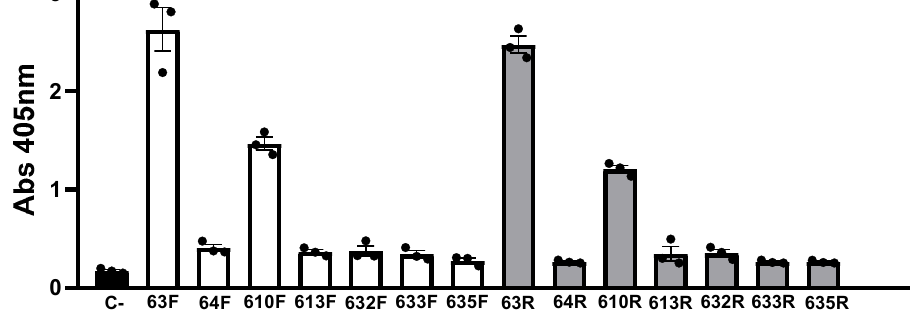
Figure 2. Study of the affinity of the F and R chains of aptamers. Plates with 100 ng/well (2.5 pmoL/well) of HAT1 protein bound to them were incubated with 100 ng/well (40 nM) of each aptamer (63F, 64F, 610F, 613F, 632F, 633F, 635F, 63R, 64R, 610R, 613R, 632R, 633R, and 635R) labeled with digoxigenin. The negative control (C-) carried no aptamer. The bars show the mean ± SEM. The data shown are from three independent experiments.